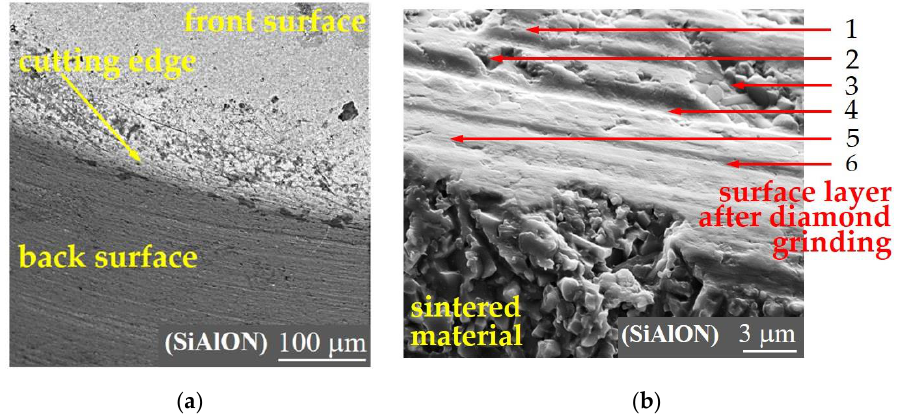
Figure 5. SEM-images of the general view of the cutting part of a round SiAlON ceramic insert ( a ) and the microstructure of the fracture boundary of sintered ceramics and the surface layer after diamond grinding ( b ): 1, micro ridges; 2, ripped-out single grains; 3, ripped-out conglomerate grains; 4, deep grooves; 5, micro cracks; 6, grooves.